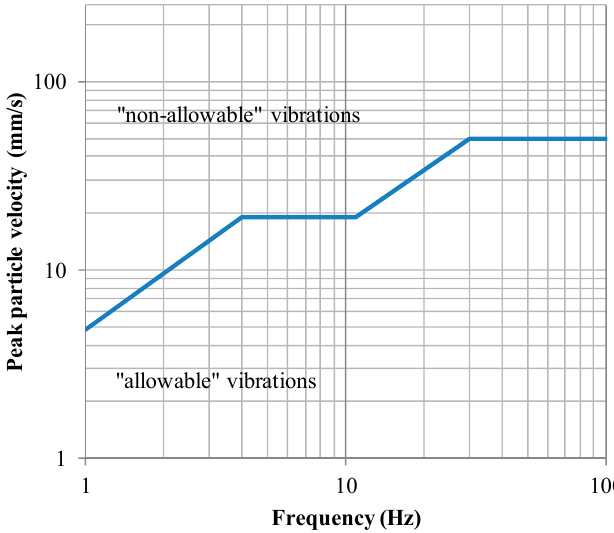
Figure 1. Safe levels of blasting vibrations for houses.